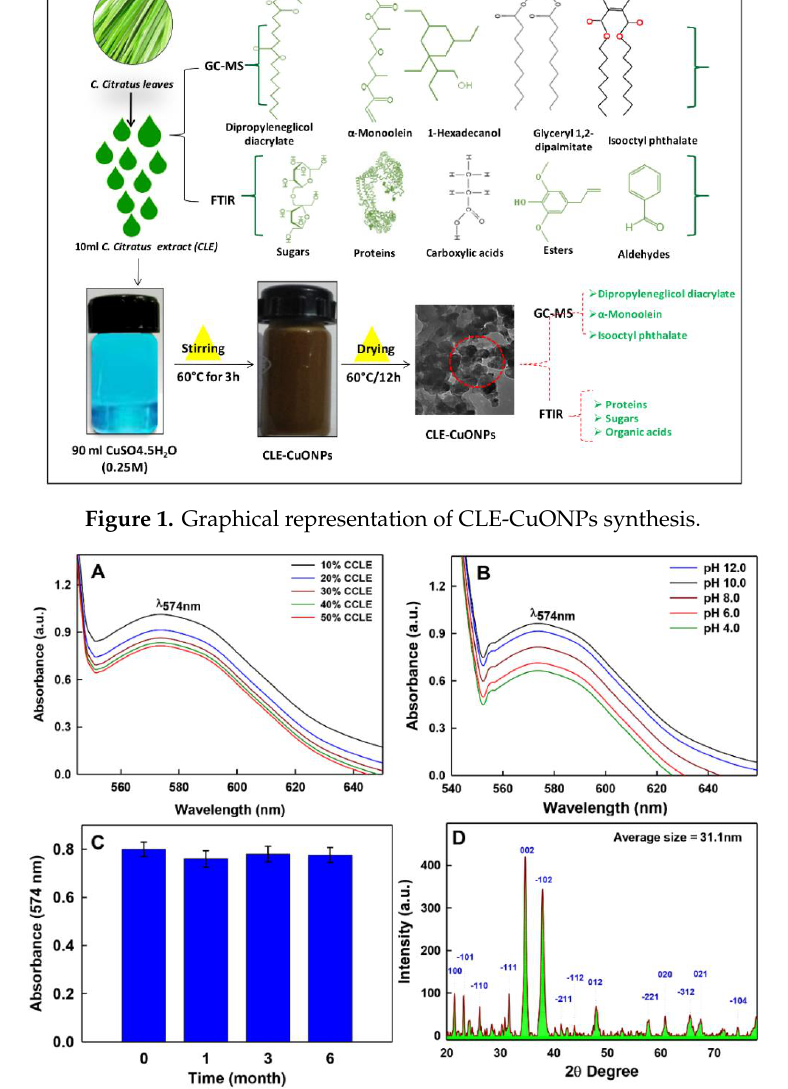
Figure 2. Physicochemical characterization of CLE-CuONPs. UV-Vis spectra-based optimization of CLE-CuONPs synthesis as a function of CLE concentration (10, 20, 30, 40 and 50%) ( A ), and pH (4.0, 6.0, 8.0, 10.0 and 12.0) ( B ) showing SPR peak at ~574 nm. ( C ) shows the stability of CLE-CuONPs based on the SPR measurements up to six months (error bars represent the mean ± SDSE of three replicates); ( D